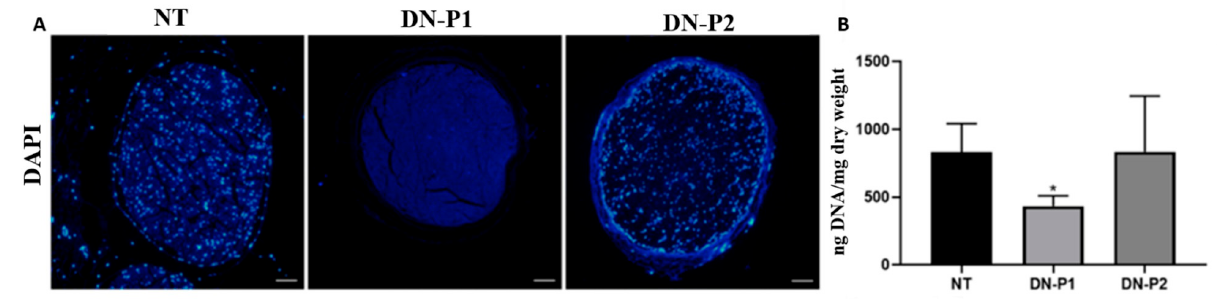
Figure 4. Qualitative and quantitative DNA content of native and decellularized rat sciatic nerves evaluating the effective- ness of the decellularization process to remove cell component. ( A ) Sections labeled with DAPI identify the cell nuclei (blue); scale bar =100 µm. ( B ) DNA quantification shows a lower DNA content in nerves decellularized with DN-P1 compared to both native tissue and nerves decellularized with DN-P2; * indicate statistically significant differences ( p < 0.05).